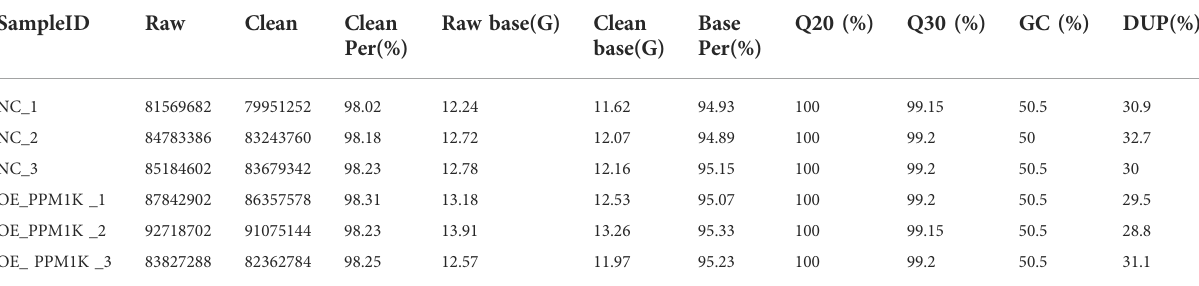
TABLE 1 Valid sequence